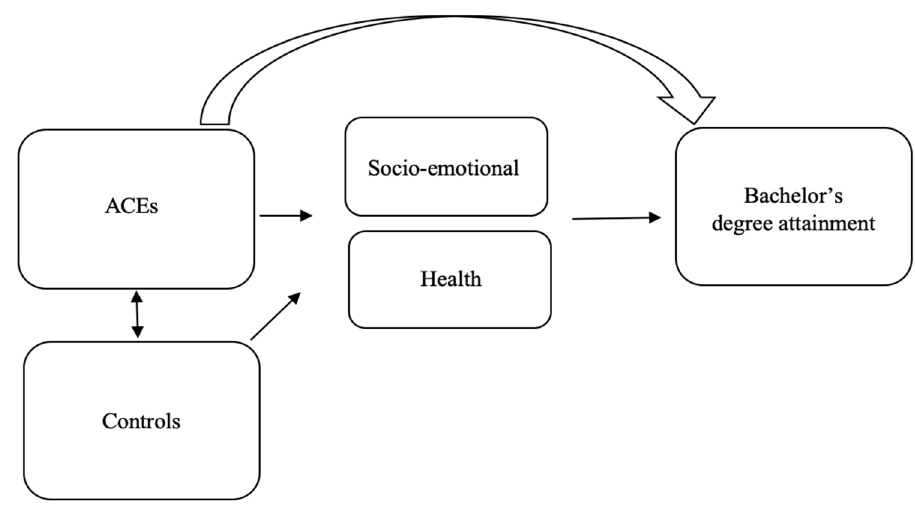
Figure 1. Conceptual Model. ACEs: adverse childhood experiences.